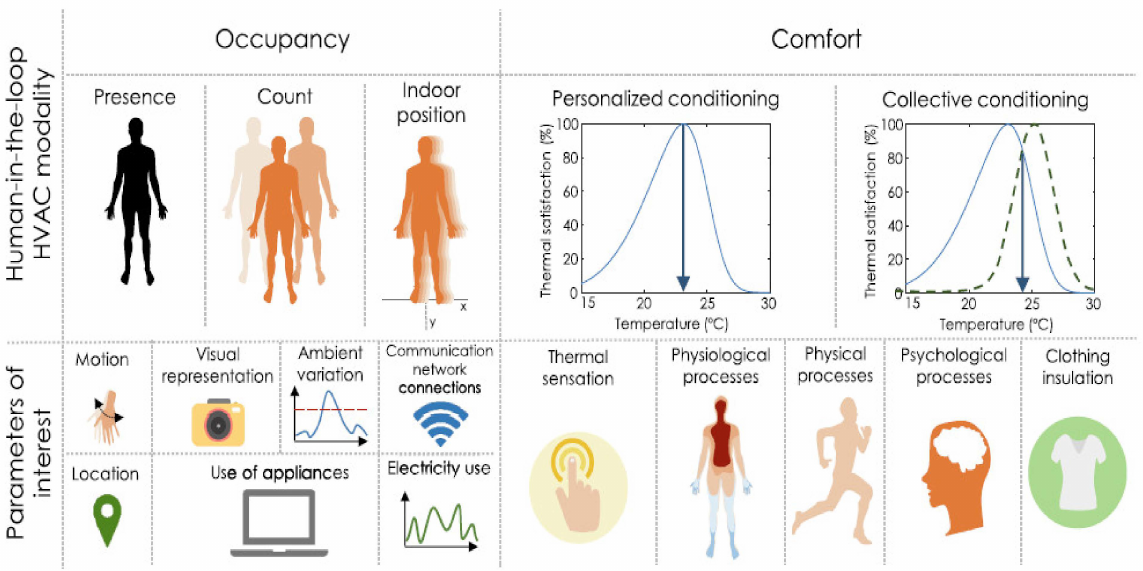
Figure 1. Human-in-the-loop HVAC modalities of occupancy and comfort along with their parame- ters of interest